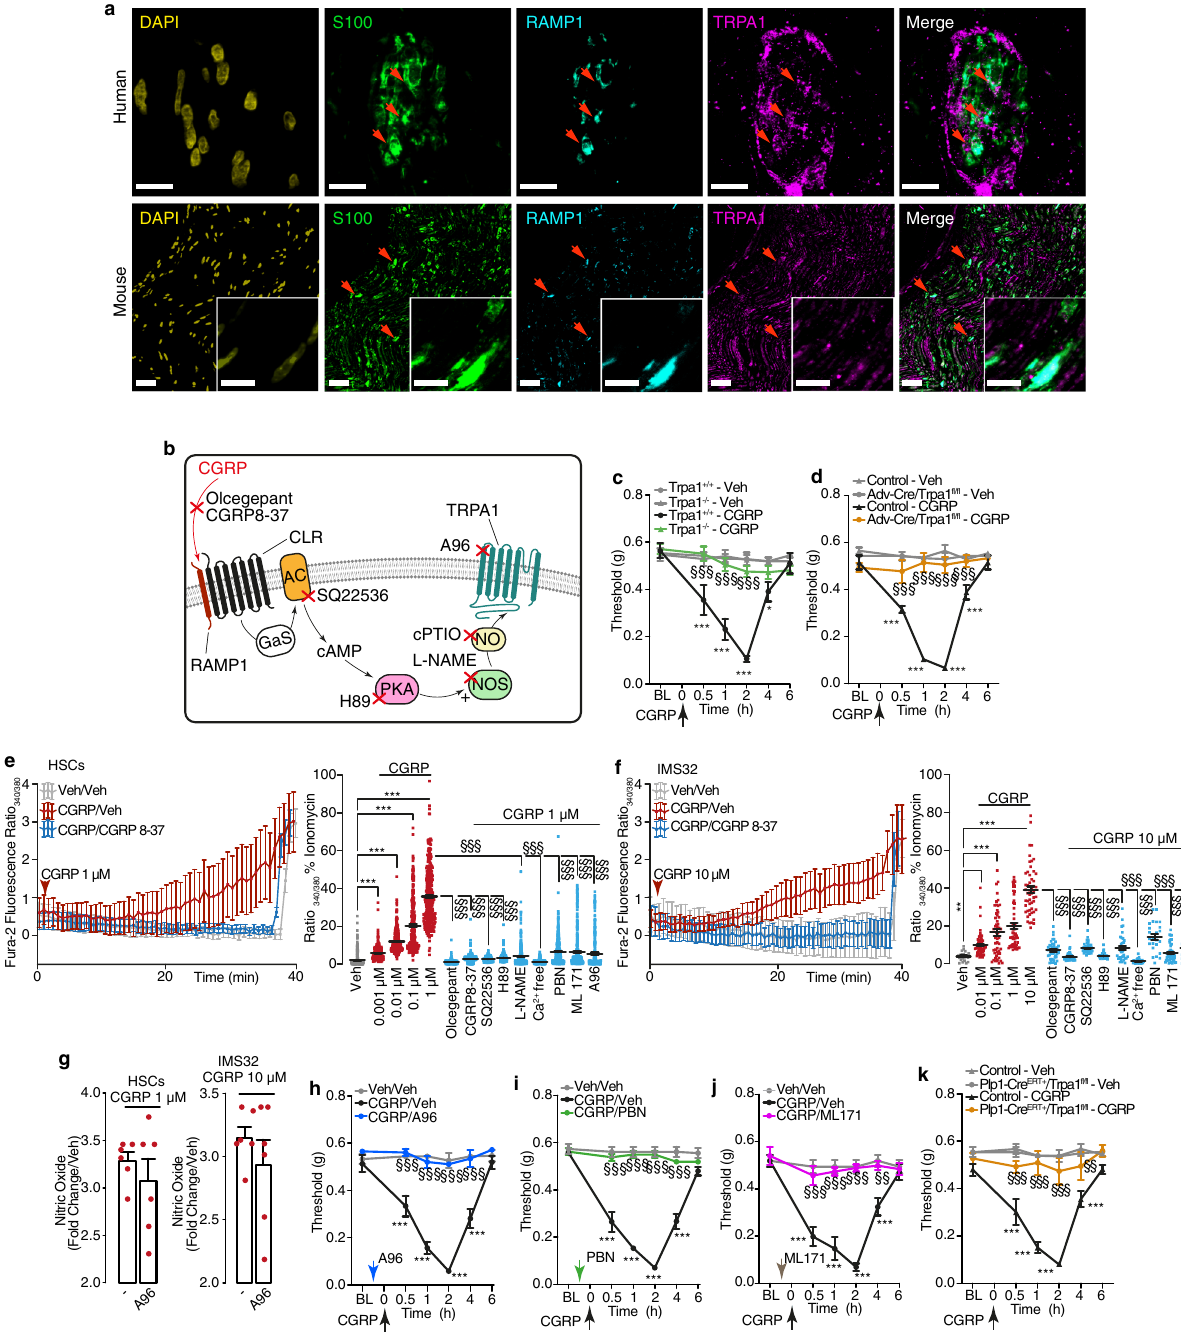
Fig. 7 CGRP induces ROS release via Schwann cell TRPA1 activation. a Representative images of localization of immunoreactive DAPI, S100, RAMP1 and TRPA1 in human abdominal and mouse periorbital cutaneous nerve bundles (Scale: 10 µ m human, 50 μ m mouse, inset 10 µ m) ( n = 3 subjects). b Pharmacological targets. c , d PMA after periorbital injection of CGRP (1.5 nmol) or vehicle in ( c ) Trpa1 + / + and Trpa1 − / − mice and in ( d ) Adv-Cre + /Trpa1 fl /